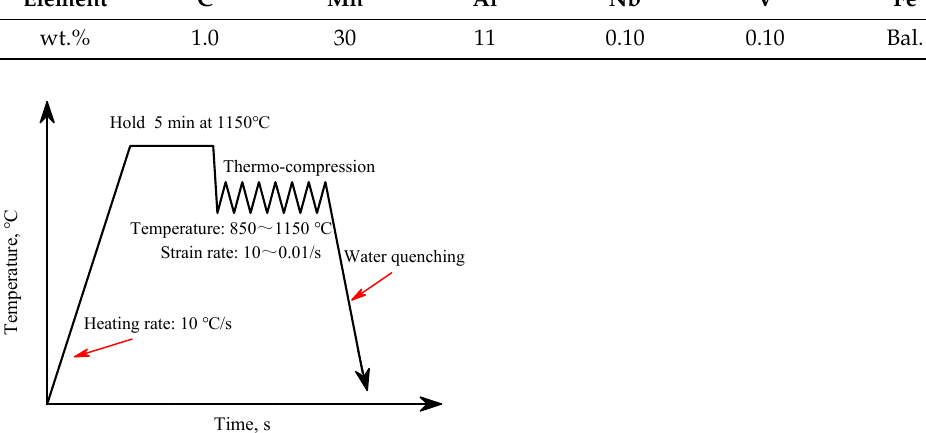
Table 1 . Chemical composition of Fe-30Mn-11Al-1C-0.1Nb-0.1V steel (wt.%). Element